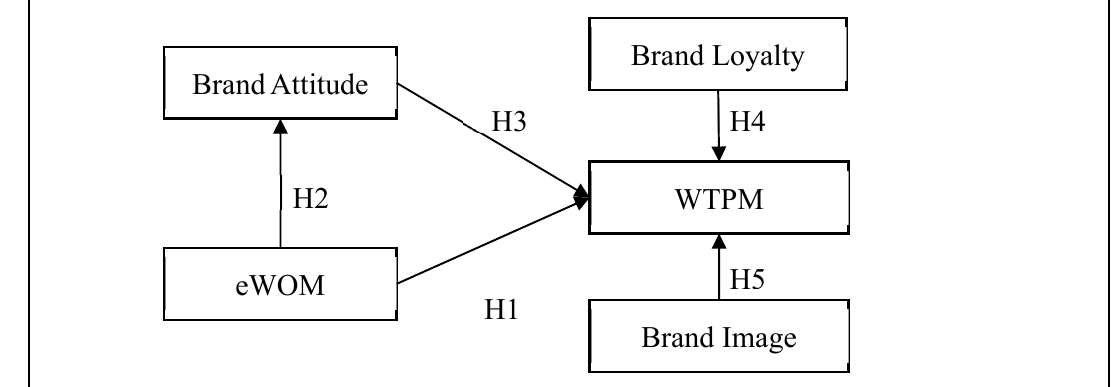
Figure 1. A conceptual framework and